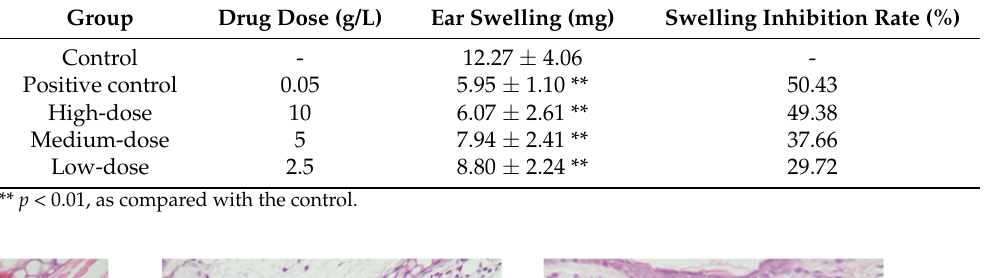
Table 3. Effect OFP on mice ear-swelling response.